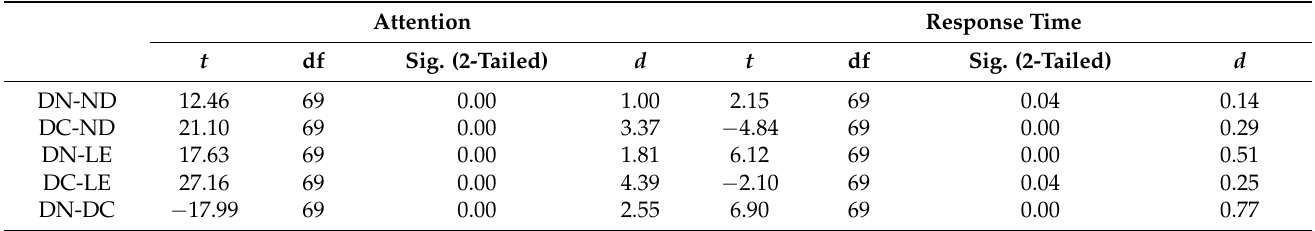
Table 2. Paired t -tests on the overall scores of attention and response times (CI = 95%).